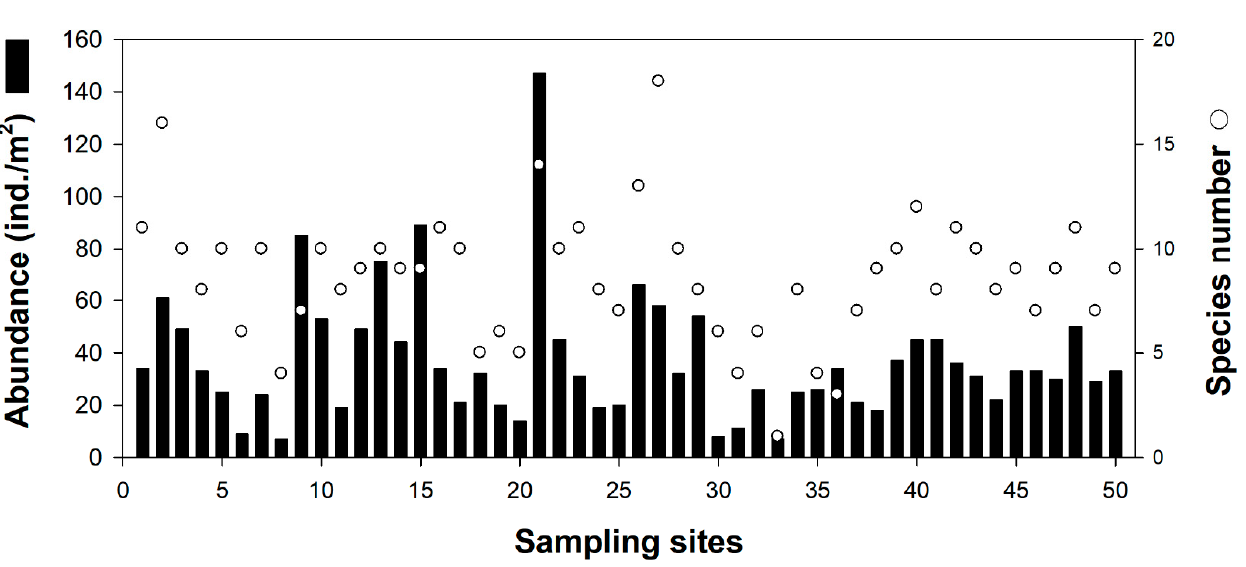
Figure 2. Abundance and species number of invertebrates from 50 sampling sites.